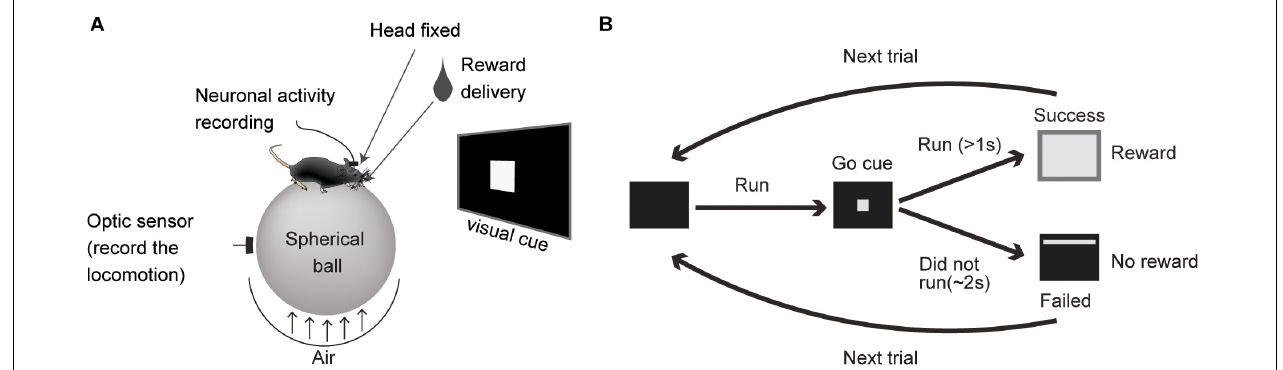
FIGURE 1 | Locomotor task. (A) A schematic for the task apparatus. (B) Diagram of the task sequence.